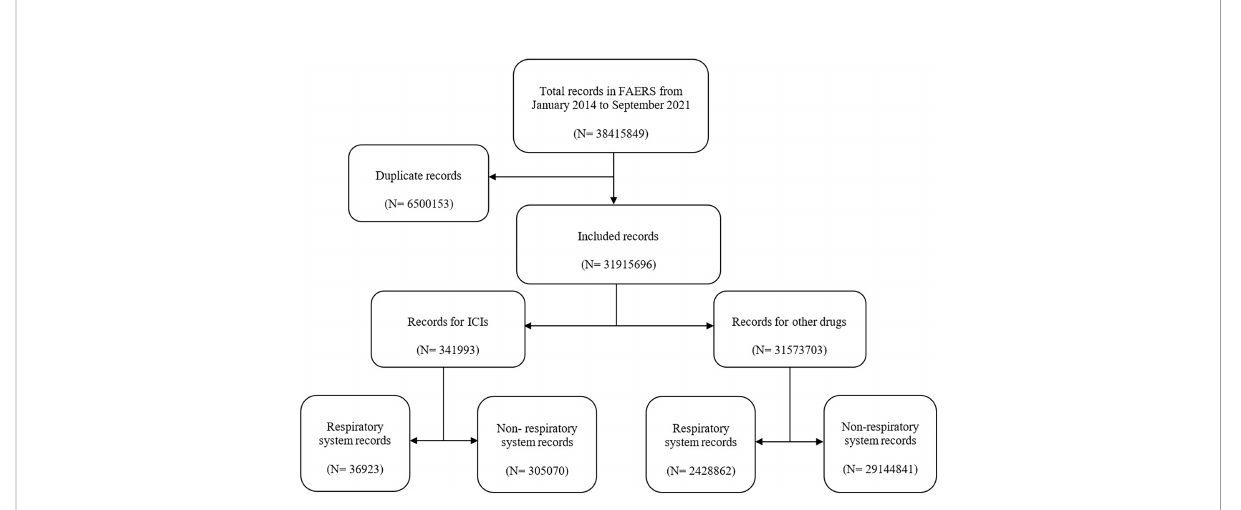
FIGURE 1 The selection process of adverse event records. ICIs, immune checkpoint inhibitors.